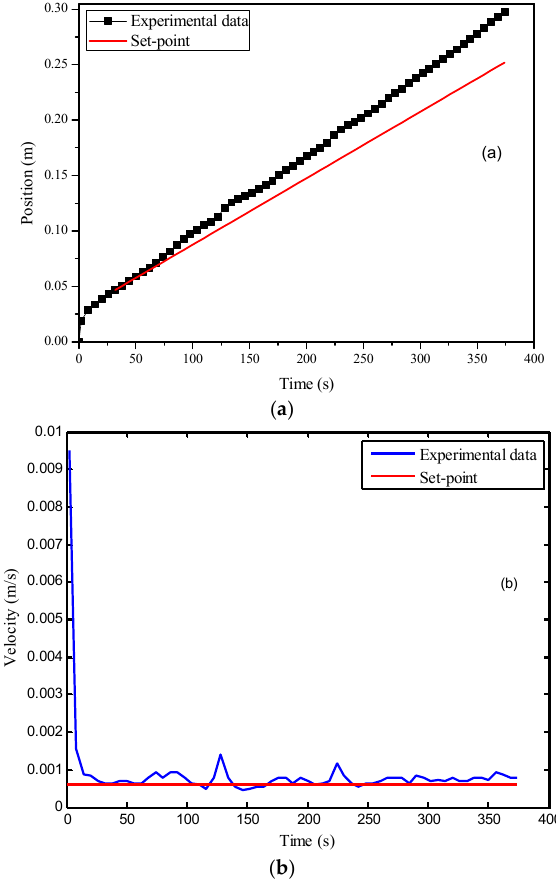
Figure 11. Control results of the MPC under model mismatch: ( a ) time vs. flow front position; ( b ) time vs. flow front velocity.